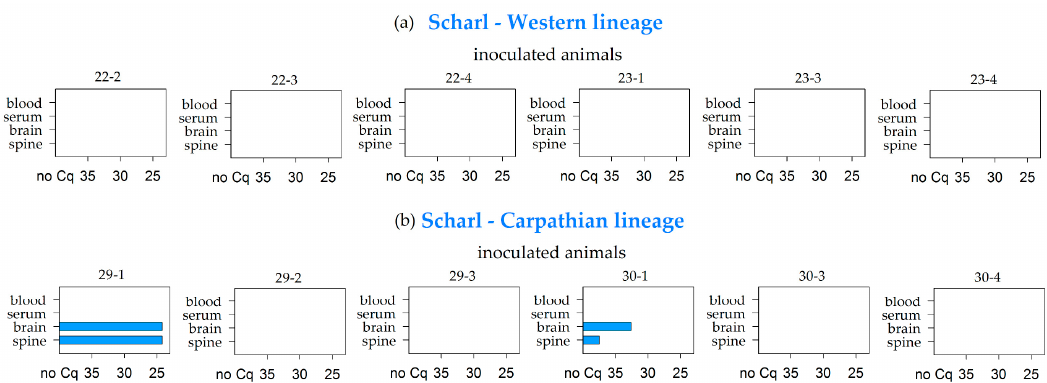
Figure 1. RT-PCR results of blood, serum, brain, and spine samples for the bank voles of the Western lineage that were inoculated with the ( a ) HM 4-2, ( b ) BaWa 15 / 943, ( c ) Neudörfl, and ( d ) HB 171 TBEV-Eu strains. Further additional positive samples are listed per animal. Measures are given in quantification cycle values (Cq). S.int.: small intestine.